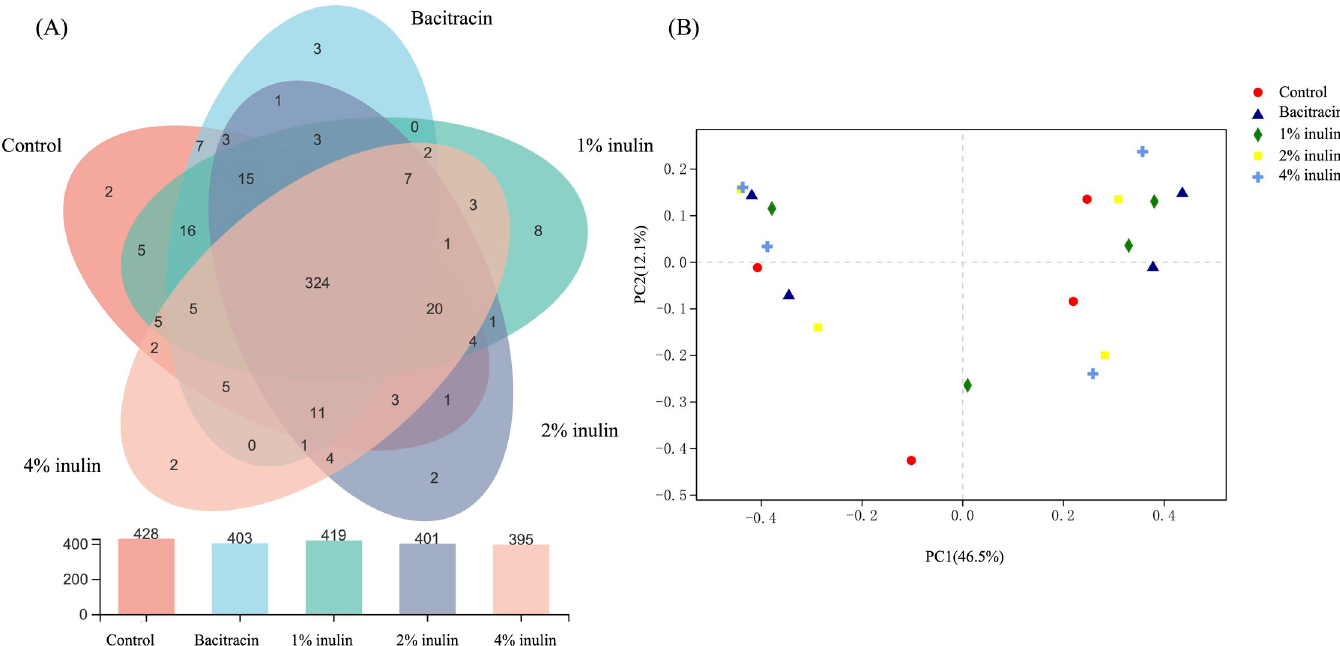
Fig 1. Effects of dietary supplementation with bacitracin and inulin on the distribution of bacterial OTUs and community composition in the cecal microbiota of broiler chickens. (A) Venn diagram showing the occurrence of bacterial OTUs identified in 16S rRNA sequencing of cecal microbiota of chickens. (B) Grouping of cecal bacterial communities based on principle component analyses of Illumina sequencing of 16S rRNA amplicons (V3-V4 region).